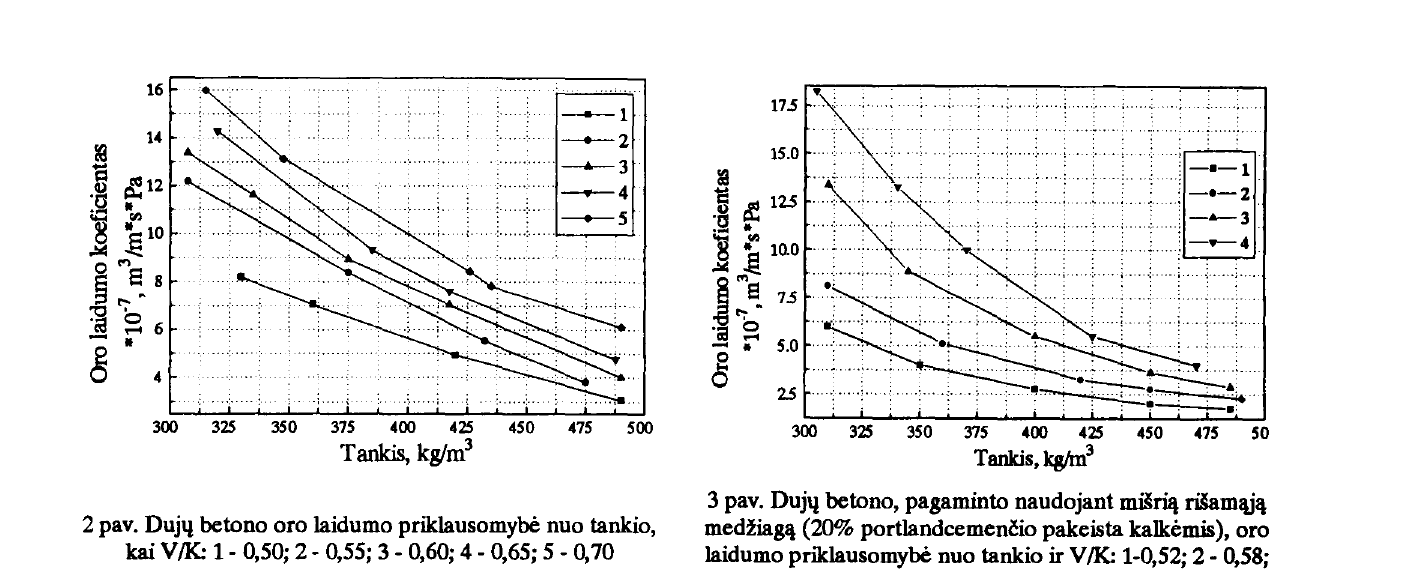
Fig. 2. Porous concrete air penetrability dependency at water/solids ratio (V/K:): 1- 0,50; 2- 0,55; 3- 0,60; 4- 0,65; Fig. 3. Porous concrete, made using a mixed binder 20% 5-0,70 Portland cement replaced by lime, air penetrability dependency on density and water/solids ratio (V IK:): 1 - 0,52; 2 - 0,58; 3 - 0,62; 4 - 0,65 Dujq betono su nmria riSanu\ia medfiaga oro laidumo koeficientai pateikti 2 lenteleje ir 3 pav.